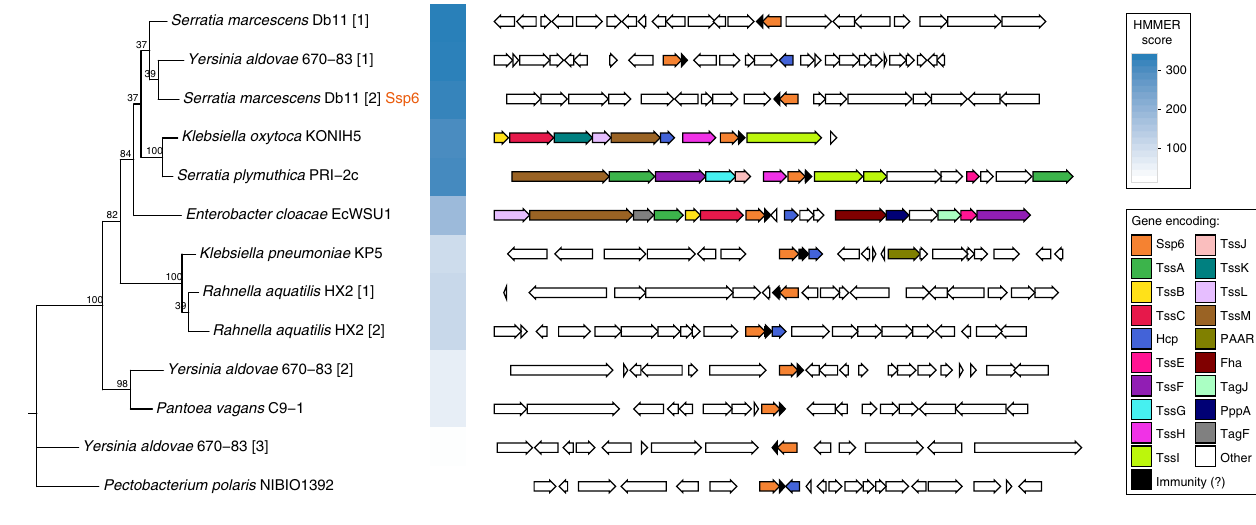
Fig. 6 Genes encoding Ssp6-like effectors are widespread in Enterobacteriaceae and can be linked with T6SS genes. Phylogenetic tree of selected Ssp6 homologues identi fi ed using HMMER homology searching of complete bacterial genomic sequences (left) and the genetic context of the corresponding encoding gene (right). Where a particular organism encodes more than one Ssp6 homologue, each homologue is indicated by square brackets after the organism name. Bootstrap values are indicated on the tree and the scale indicates number of substitutions per site. In the genetic loci, conserved T6SS genes are coloured as per the legend; Ssp6 homologues are orange and genes encoding known or putative immunity proteins are black. The full set of identi fi ed homologues and details of the bacterial genome sequences can be found in Supplementary Fig. 9 and Supplementary Data